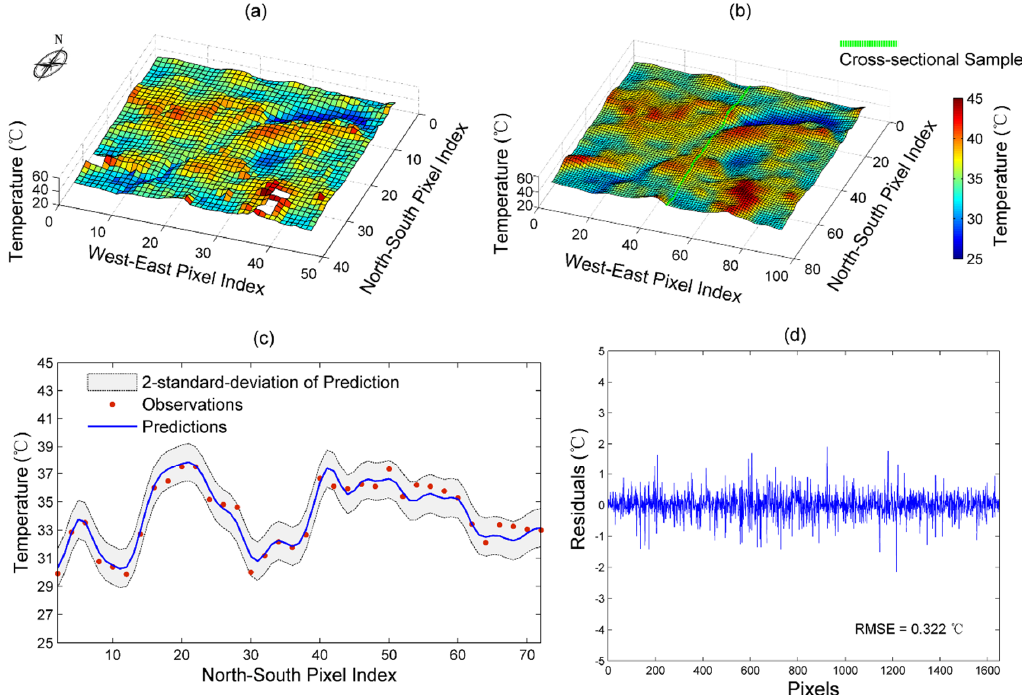
Figure 3. The latent LST recovered from the original observation acquired by satellite. ( a ) The original image at 13:30 on 27 July 2012; ( b ) The recovered continues latent LST pattern; ( c ) The difference between the observations and the latent LST; ( d ) The residuals due to recovery.